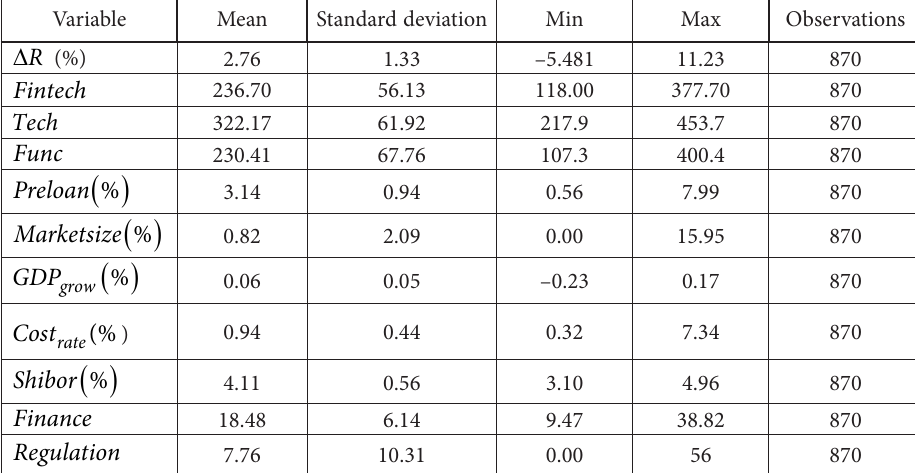
Table 1. Descriptive statistic of